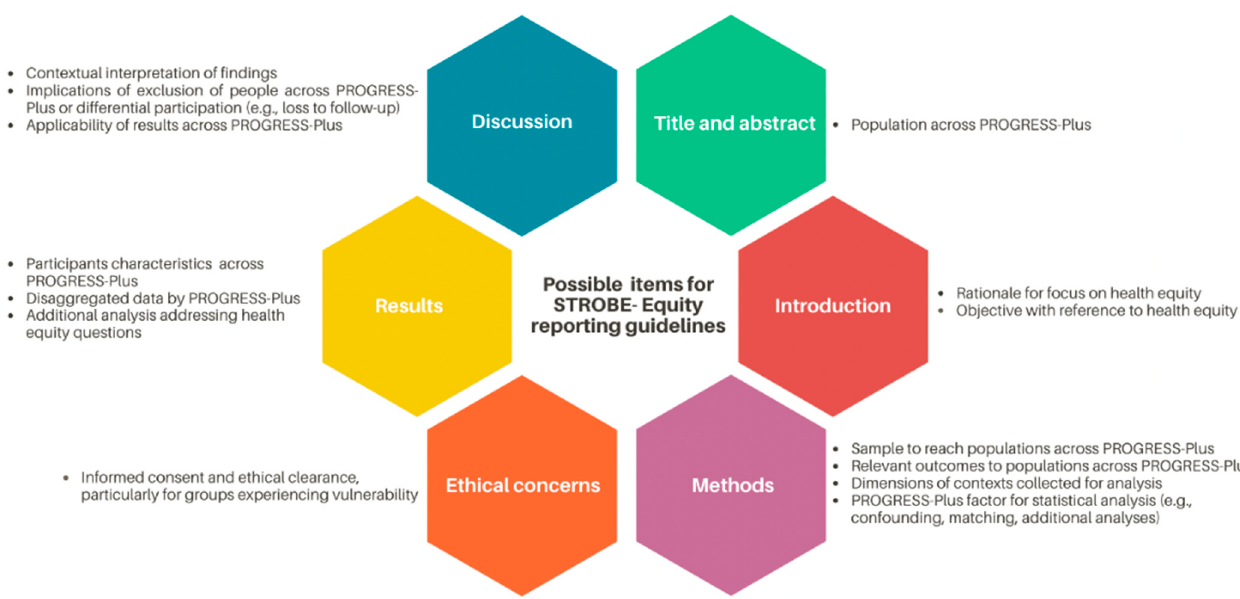
Figure 1. Possible items for STROBE- Equity reporting guidelines. Abbreviations: PROGRESS-Plus, Place of residence, Race/ethnicity/culture/language, Occupation, Gender or sex, Religion, Education, Socioeconomic status, Social capital, and other contextual factors that facilitate disadvantage.